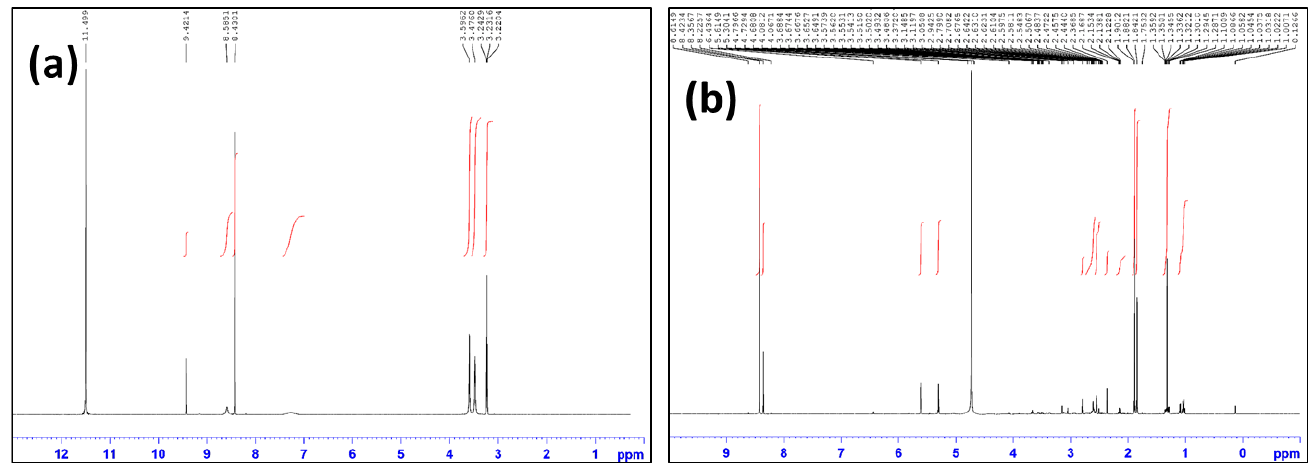
Figure 5 1 H-NMR spectrum of ( a ) MOF-808 (deutriated TFA) and ( b ) C-MOF-808 (D 2